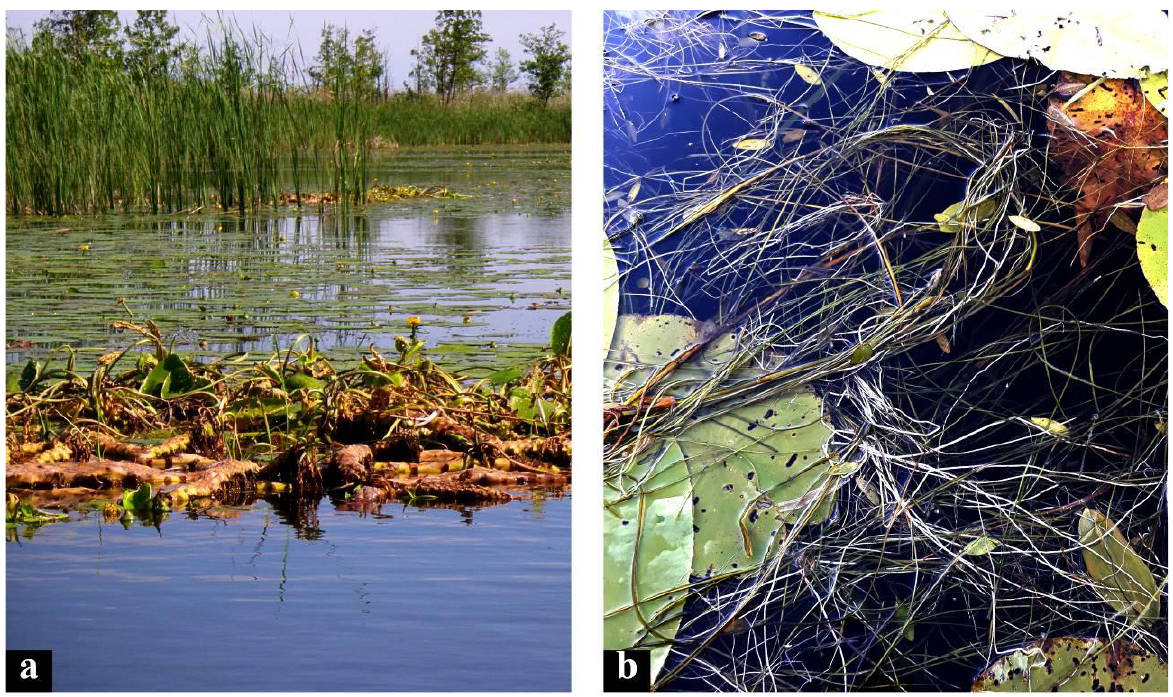
Figure 6. Aggregations of uprooted Nuphar lutea rhizomes ( a ), and uprooted individuals of Caldesia parnassifolia ( b ). Photos by Z. Sinkevičienė.